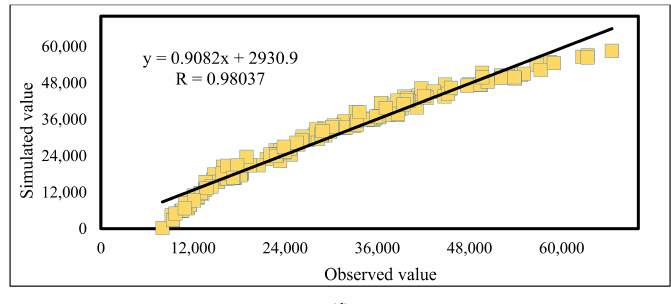
Figure 5. Correlation assessment of the testing data for ( a ) EWA-ANFIS, ( b ) PSO-ANFIS, ( c ) SSA- ANFIS, and ( d )